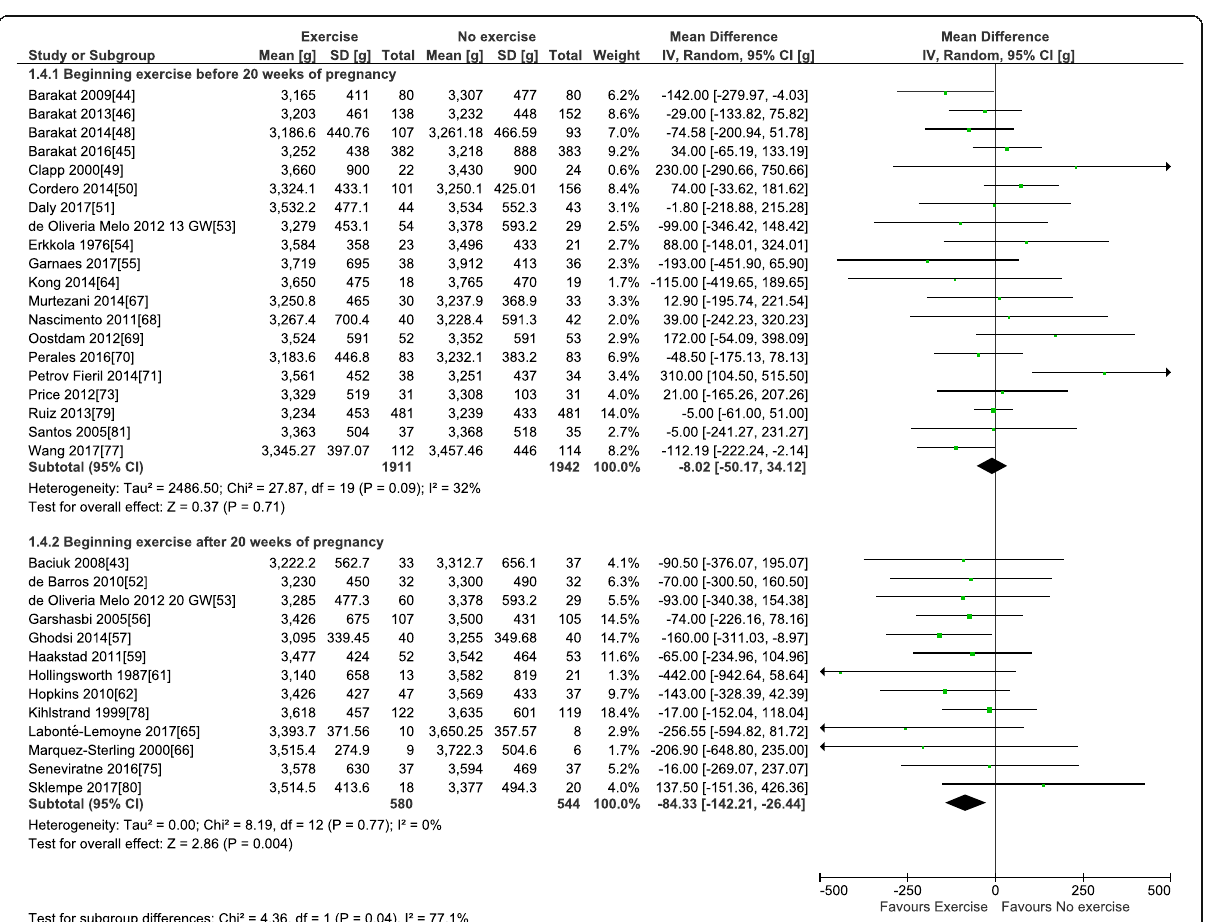
Fig. 5 Forest plot of pooled mean differences for birth weight after exposure to prenatal exercise vs. no exercise; sub-grouping by timing of intervention: first half of pregnancy (< 20 gestational weeks) vs. second half of pregnancy ( ≥ 20 gestational